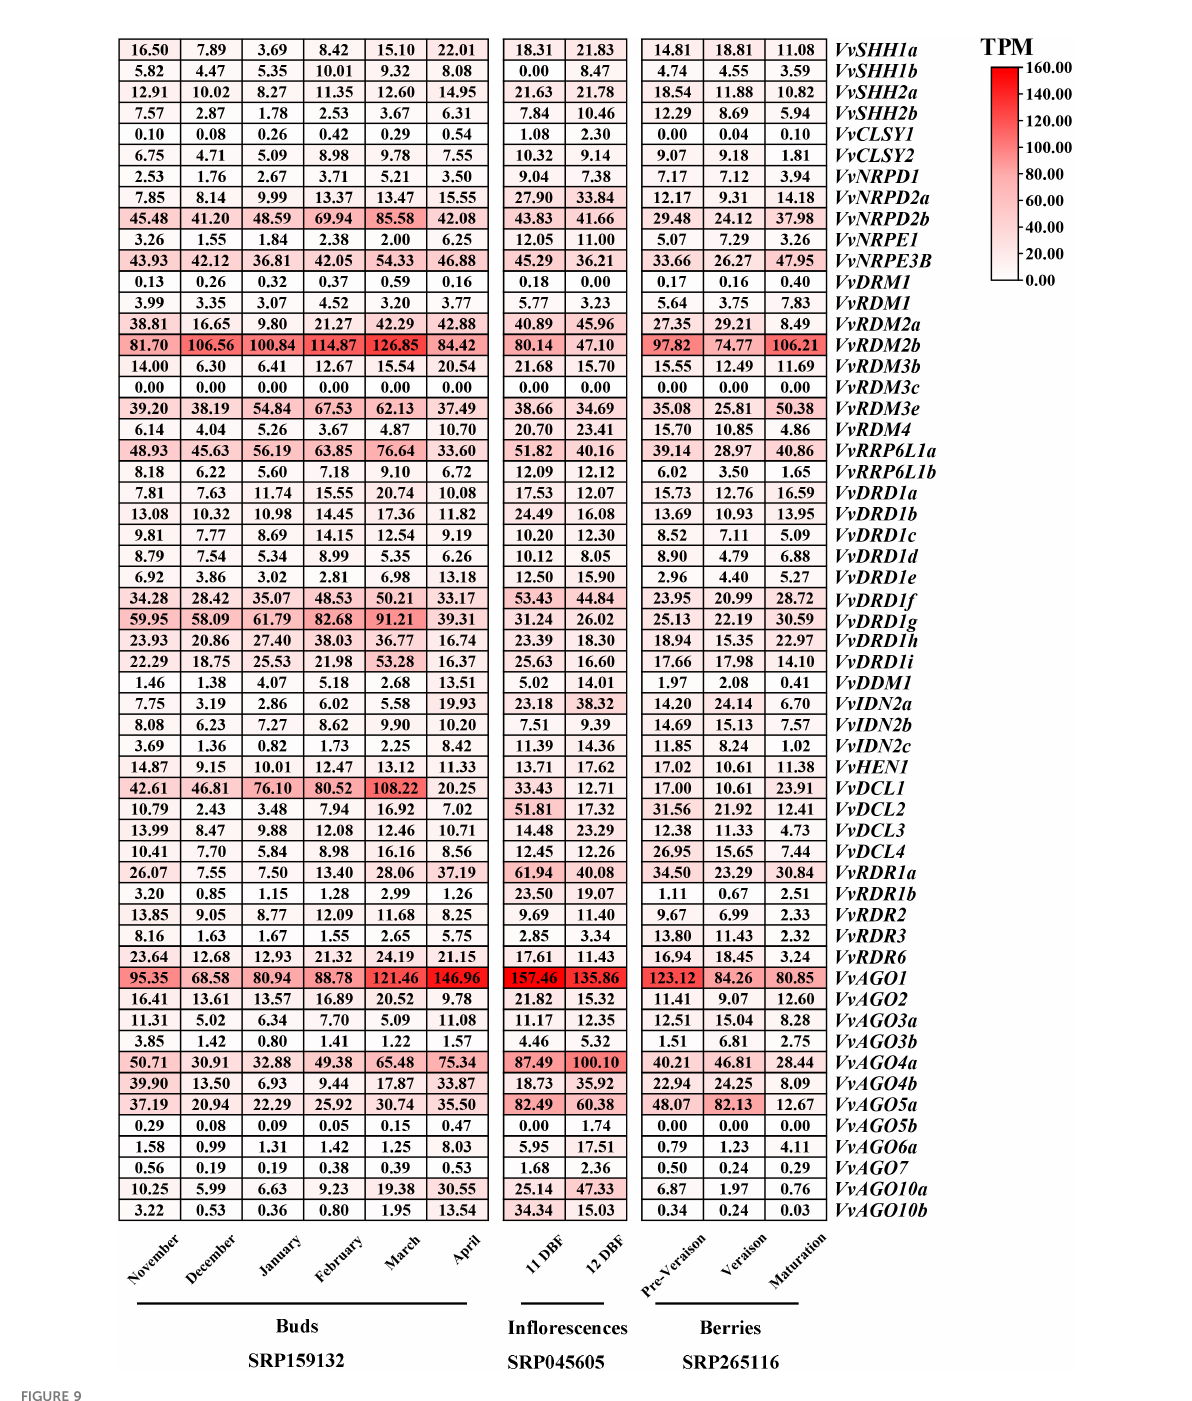
FIGURE 9 Transcriptomic expression of VvRdDM genes in different organs at various periods of time. The bud samples were collected at every month from November to April. The in fl orescence samples were taken at 11 and 12 days before fl owering (DBF). The fruit samples were collected at three developmental stages (pre-veraison, veraison, maturation). Transcriptome data were downloaded from the NCBI SRA datasets (SRP159132, SRP045605 and SRP265116). The white and red color scale denotes low and high expression levels, respectively. No gene expression is denoted with grey color. Numbers denote TPM of VvRdDMs